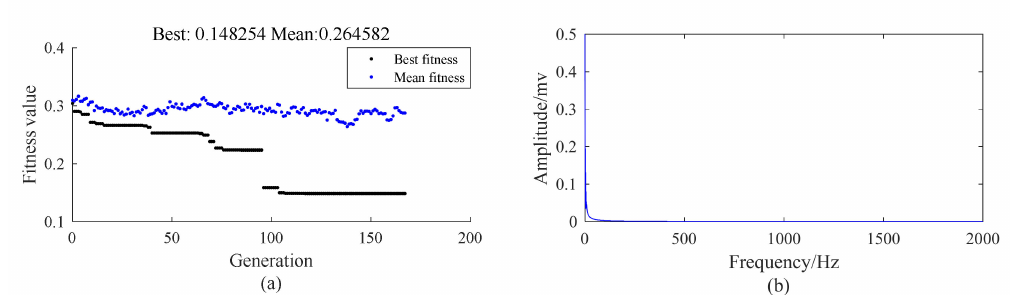
Figure 19. The diagnosis result of the simulation signal of the bearing with the inner race fault processed by the Optimal Wavelet Packet Transform (OWPT): ( a ) the training performance of the OWPT; ( b ) the squared envelope spectrum